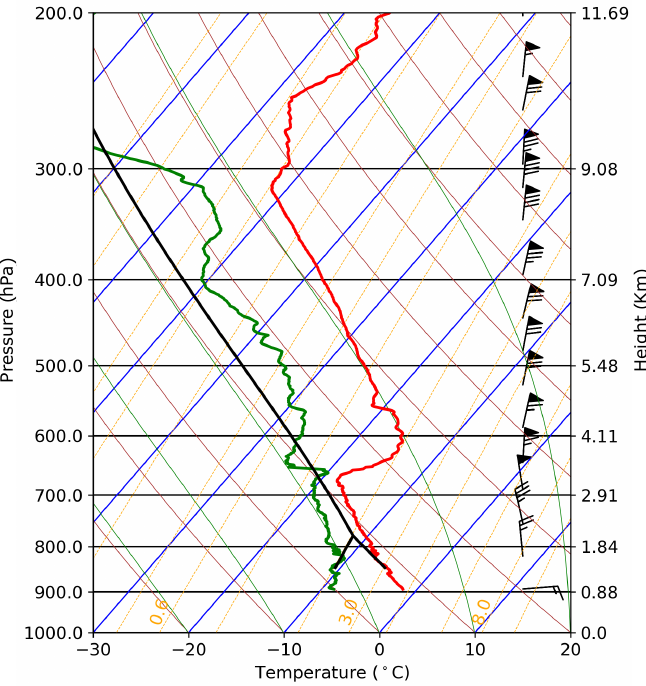
Figure 3. Atmospheric sounding at Das launched on 15 Jan 2017 at 12:37